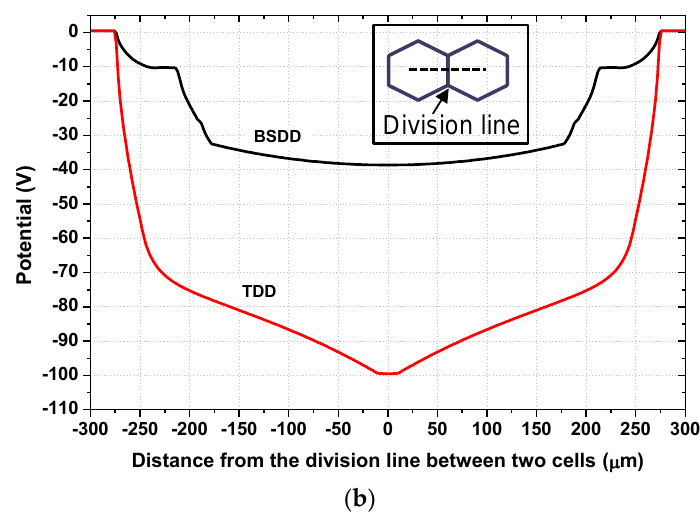
Figure 12. ( a ) Electrostatic potential distribution and ( b ) electric potential along the drift valley for multi-cell TDD and BSDD devices, plotted from anode to anode in two neighboring cells.